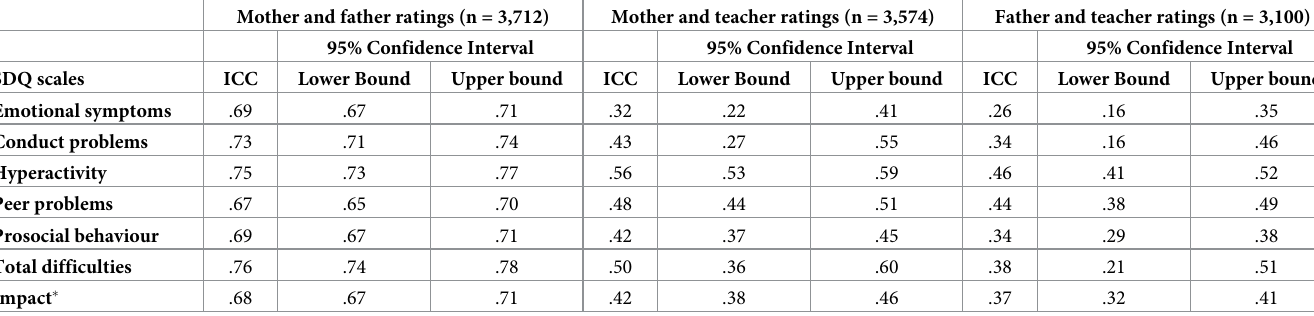
Table 5. Inter-rater agreement for SDQ scores.